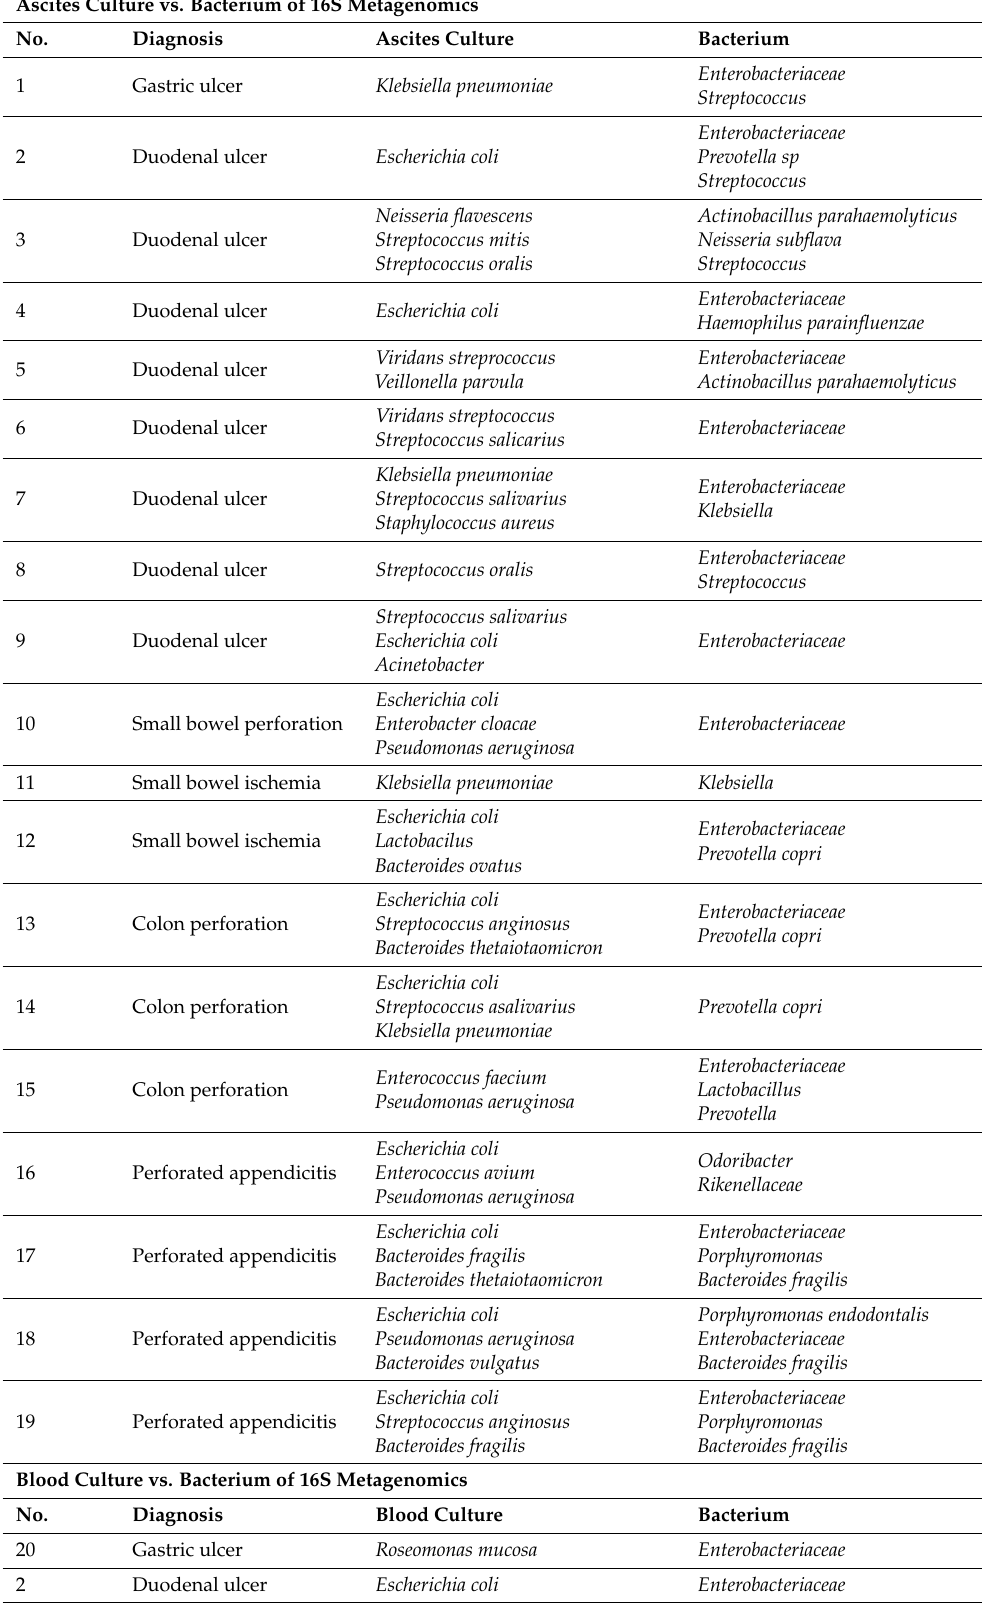
Table 2. Comparison of metagenomic bacterium and conventional culture in the ascites and blood. Ascites Culture vs. Bacterium of 16S